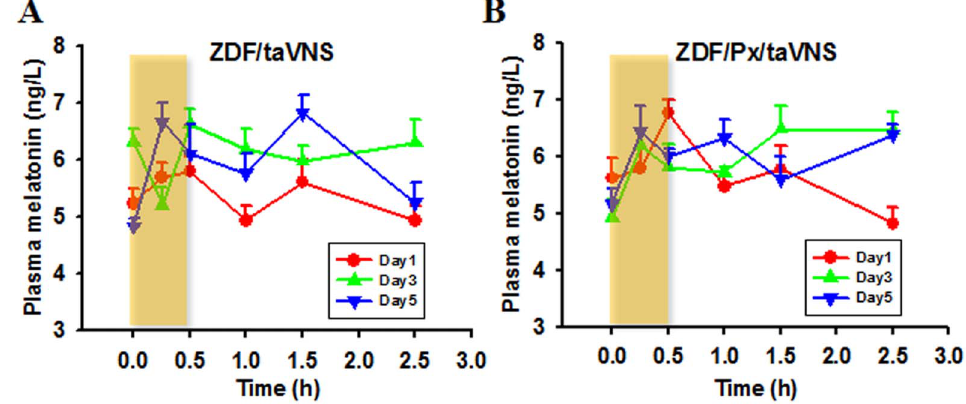
Figure 2. Acute plasma melatonin concentration change upon taVNS. Showing that each taVNS administration (shielded area) would trigger acute and tidal melatonin secretion in pineal intact (A) and pinealectomized ZDF rats (B). Note that the melatonin secretion tides existing both during and after tsVNS session and that the after-taVNS tides tended to be higher (A and B) or more frequent (B) with the increase of treatment days.